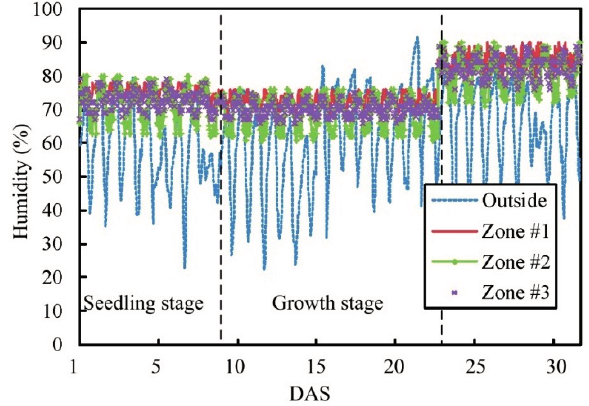
Figure 12. Comparisons of temperature parameter changes between Zone #1 to Zone #3 (under automatic mode).